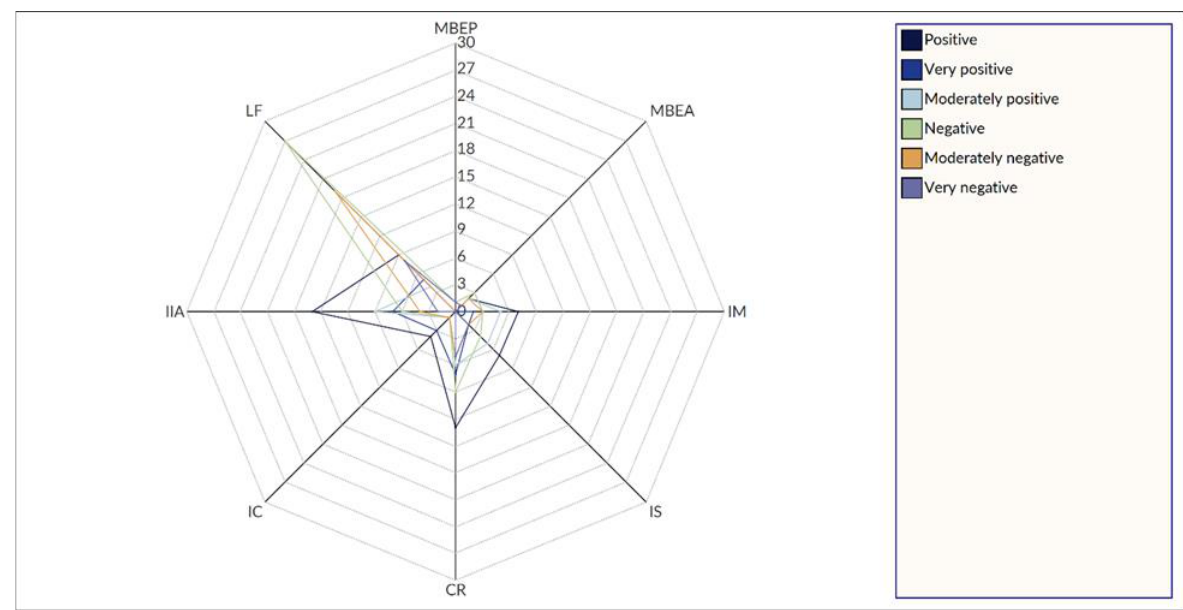
Figure 4. Matrix coding spider web diagram.